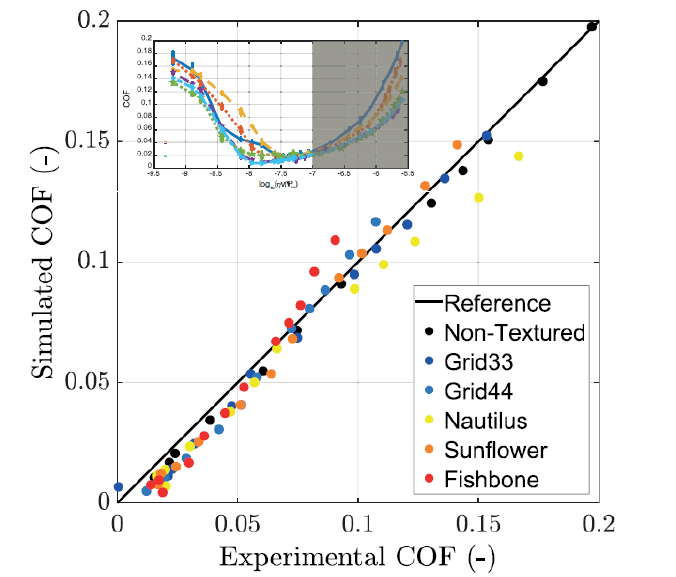
Figure 9. Simulated vs experimentally measured friction coefficient. In the inset, where the experimental Stribeck curve is shown, the speed range, where the comparison is carried out, is